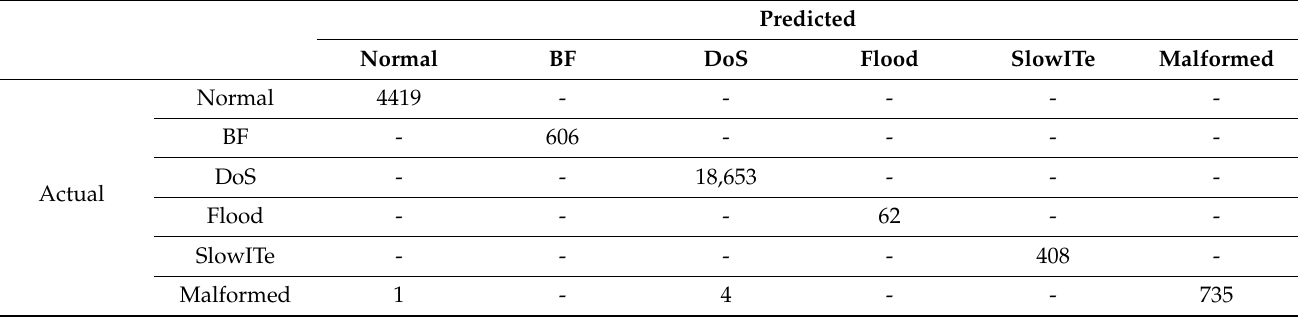
Table 4. Confusion matrix of our method.